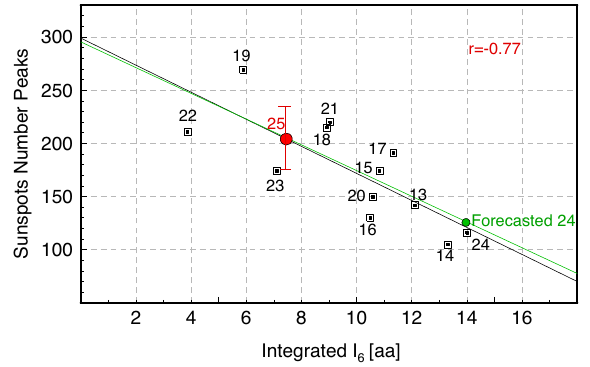
Fig. 2. As in Figure 1, the linear regression of I 6 [ aa ] integrated over the descending phase of each solar cycle versus the sunspot peaks of the following cycle. The expected peak of SC 25 is represented by the red circle (con fi dence level is obtained as root mean square error). Green circle represents SC 24 forecasted by using the regression computed over SCs from 14 to 23 (represented by the green line).